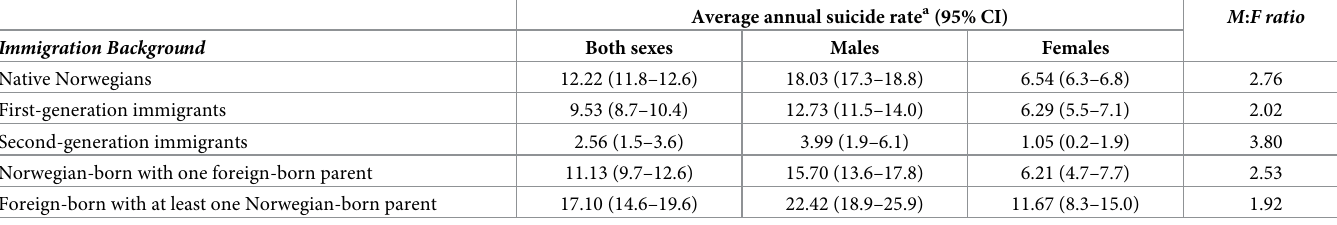
Table 1. Suicide rate (per 100,000 population) by immigration background,